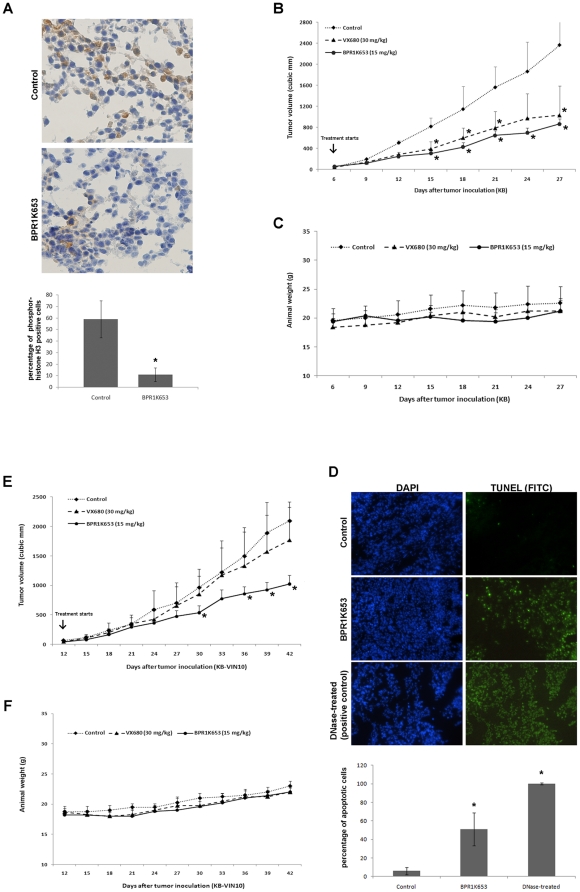
Inhibition of human xenografts growth in vivo by BPR1K653.(A, B, C and D) Nude mice bearing human cervical carcinoma KB xenografts were treated with vehicle control (⧫), 30 mg/kg VX680 for 5 days/week for 2 weeks (on days 6–10 and 13–17; ▴) or 15 mg/kg BPR0L075 for 5 days/week for 2 weeks (on days 6–10 and 13–17; •). (A) BPR1K653 treatment reduced the amount of the phosphor-Histone H3 positive cells present in tumor tissues. Immuno-histochemical analysis of the expression of phosphor-Histone H3 in the tumor tissue sections 24 h after the second BPR1K653 administration. Nucleus was stained blue/purple by hematoxylin and phosphor-Histone H3 was labeled in brown colour. Labeled cells were counted, and percentage of the phosphor-Histone H3 positive cells present in tumor tissues was calculated as follows: Total amount of cells with brown color labeled ÷ Total amount of cells available×100. Experiment was repeated twice. A statistically significant difference in the amount of phosphor-Histone H3 positive cells present in tumor tissues in mice treated with control versus BPR1K653 is denoted by “*”. *p<0.05. (B) Measurement of tumor volume. A statistically significant difference in tumor size in mice treated with control versus BPR1K653 and VX680 is denoted by “*”. *p<0.05. (C) Measurement of animal weight. (D) TUNEL analysis of the tumor tissue sections 12 days post-BPR1K653 treatment. Tumor tissue sections were analyzed by the FITC In Situ Cell death detection kit and fluorescent microscopy. Tissue treated with DNase was used as the positive control. Green fluorescence labeled nucleus indicates the induction of DNA fragmentation. Experiment was repeated twice. Quantitative analysis was shown. A statistically significant difference in the amount of apoptotic cells present in tumor tissues in mice treated with control versus BPR1K653 is denoted by “*”. *p<0.05. (E and F) Nude mice bearing the P-gp170/MDR-expressing KB-VIN10 xenograft was treated with vehicle control (⧫), 30 mg/kg VX680 for 5 days/week for 3 weeks (on days 12–16, 19–23 and 26–30; ▴) or 15 mg/kg BPR0L075 for 5 days/week for 3 weeks (on days 12–16, 19–23 and 26–30; •). (E) Measurement of tumor volume. A statistically significant difference in tumor size in mice treated with control versus BPR1K653 and VX680 is denoted by “*”. *p<0.05. (F) Measurement of animal weight. Data are the mean ± SD of tumor volume (mm3) at each time point (n = 5; *P<0.05).